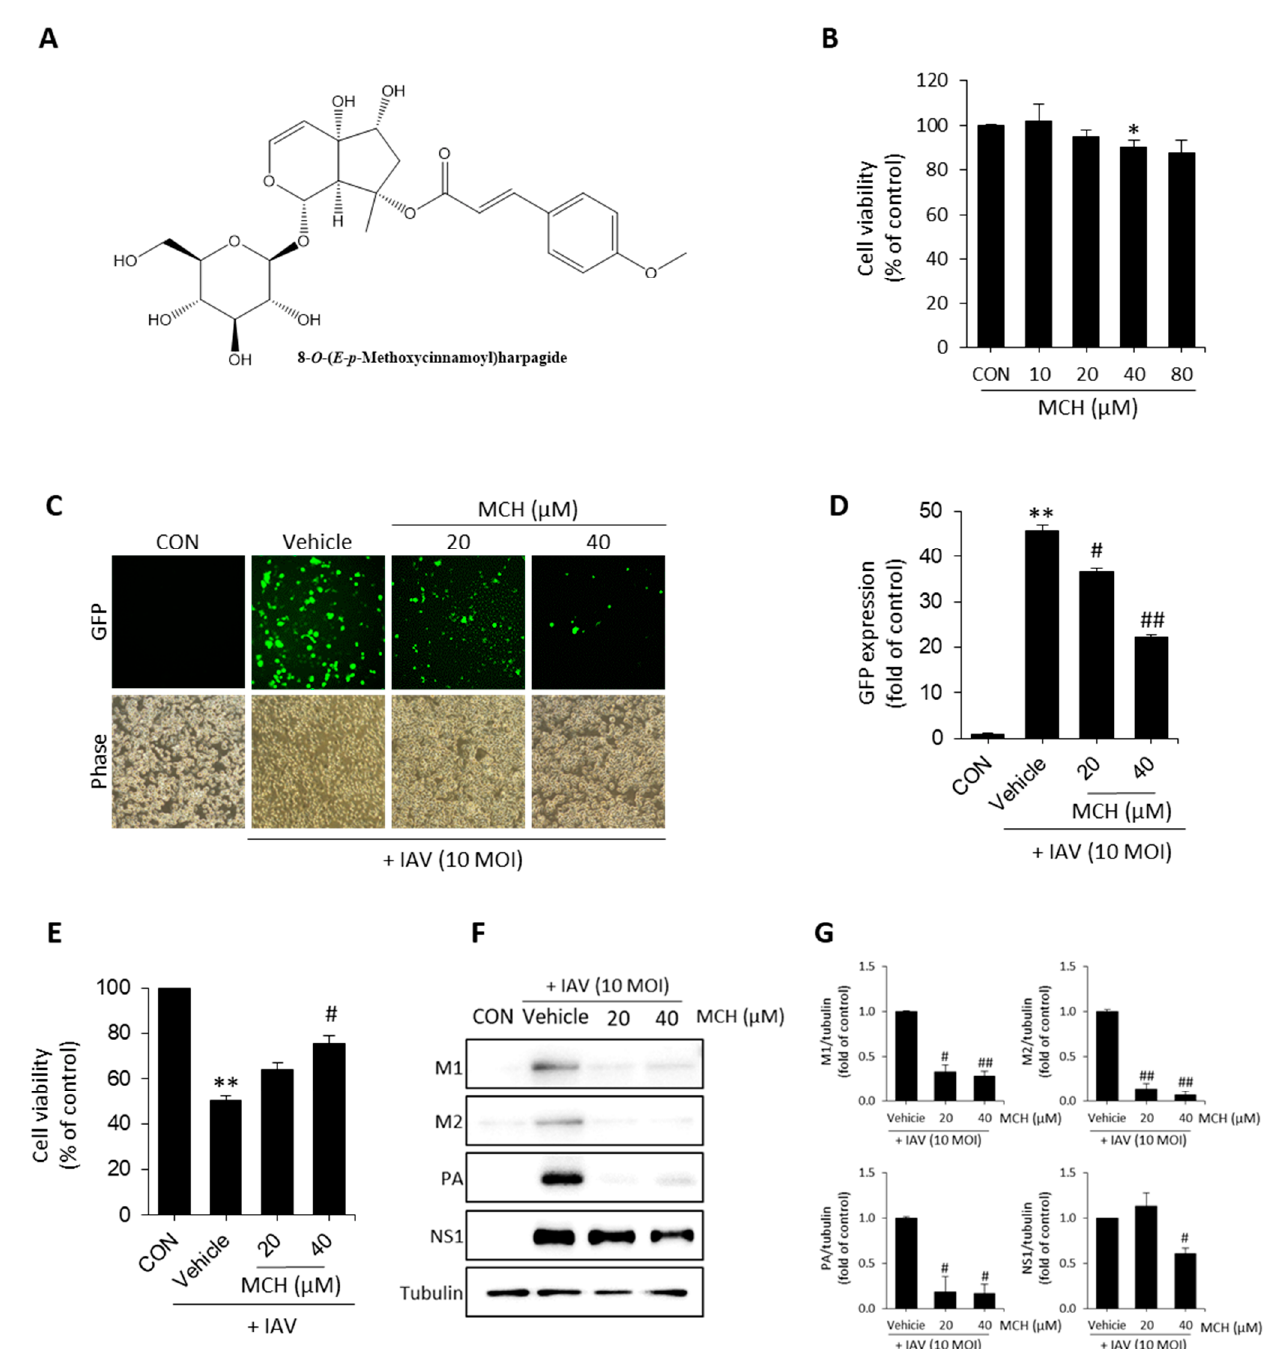
Figure 1 . Antiviral effect of 8- O -( E - p -methoxycinnamoyl)harpagide (MCH) on influenza A virus (IAV)-infected A549 cells. ( A ) Structure of MCH. ( B ) Cells were treated with MCH at various concentrations for 24 h. Determination of cytotoxicity using MTT assay. ( C , D ) Cells were infected with GFP encoded-H1N1 (A/PR8/34) virus for 2 h and then treated with MCH for 24 h before fluorescence microscopy and quantification using a flow cytometer. ( E ) Determination of antiviral effect. ( F , G ) Western blotting of viral expressions and then quantification using the Image J software. The bar graphs show the means ± SD of three independent experiments [** p < 0.01 compared with the control (DMSO), # p < 0.05 and ## p < 0.01 compared with the vehicle (IAV-infected control)].